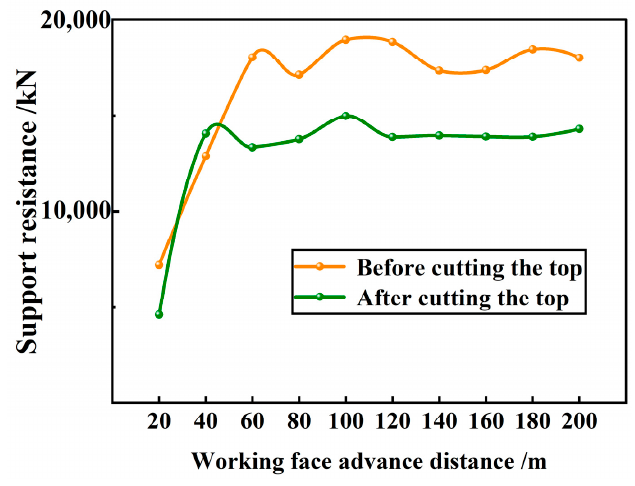
Figure 13. Force comparison of support before and after cutting the roof.